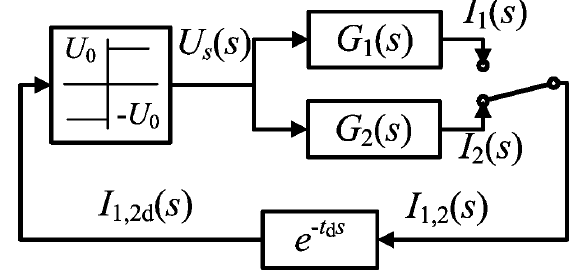
Figure 3. Block diagram of control system.